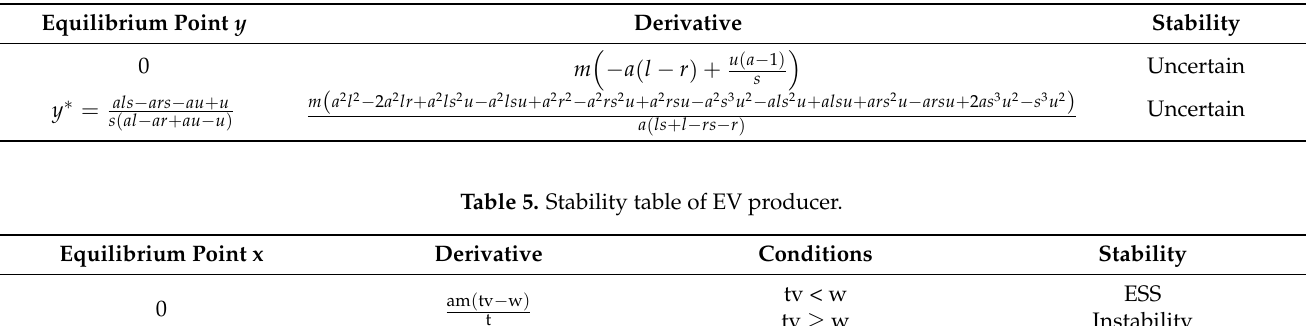
Table 4. Stability table of EV cell producer.